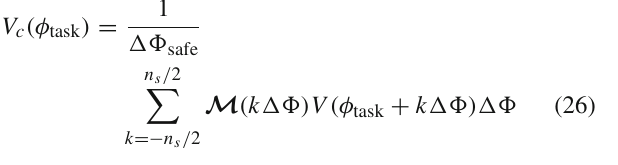
video about simulations and experiments is available on sup- plemental movie 1